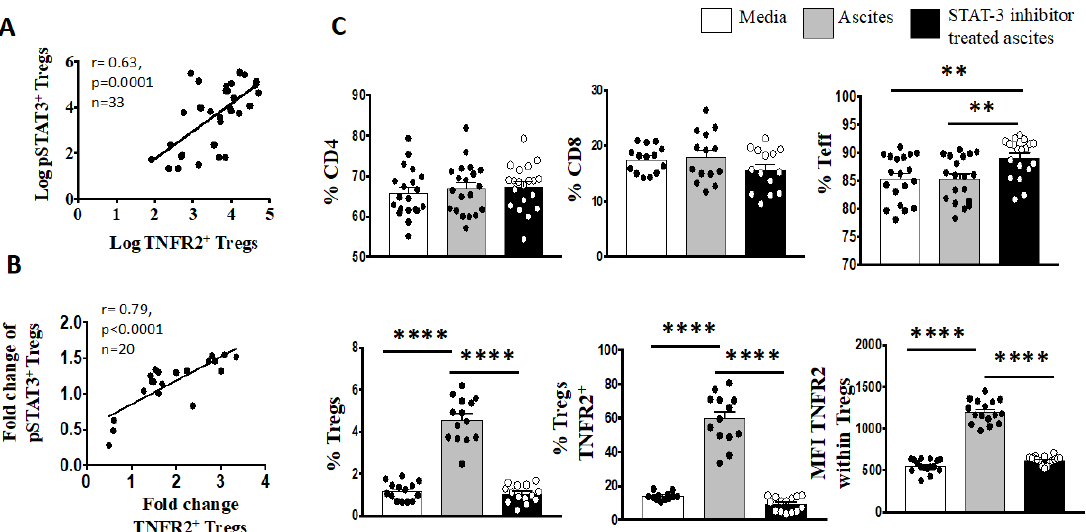
Figure 6. Blockade of pY705-STAT3 signaling decreases percentage of Tregs, as well as TNFR2+ Tregs and TNFR2 expression. ( A ) Peripheral blood mononuclear cells (PBMCs) from patients with advanced HGSOC ( n = 33) were isolated by Ficoll density centrifugation and freshly stained for surface and intracellular markers CD3, CD4, CD25, TNFR2, FoxP3 and pSTAT3 and analysed with flow cytometry. ( B , C ) PBMCs from healthy donors ( n = 20) were isolated by Ficoll density centrifu- gation and incubated in vitro in media or cell-free ascites from advanced EOC patients for 48 h. pY705-STAT3 activity was inhibited by the addition of 50 μM S3I-201 into the culture at day 0. In untreated media and ascites, vehicle control DMSO at 0.05% was added at day 0. Cells were washed, labeled for surface and intracellular markers CD3, CD4, CD25, TNFR2, FoxP3 and pSTAT3, and analysed with flow cytometry. ( A , B ) Correlation of the percentage of pSTAT3+ Tregs to TNFR2+ Tregs (log) in patients with advanced HGSOC. B. Correlation of the fold change of pSTAT3+ Tregs to TNFR2+ Tregs in healthy donors PBMC following incubation in ascites of EOC patient, p < 0.05 is significant. ( C ) The frequency (%) of CD4, CD8, Teff and Tregs as well as the percentage of TNFR2 and level of TNFR2 expression (median fluorescence intensity, MFI) within Tregs within media (white bar), ascites (grey bar) and following blockade with STAT3 inhibitor (black bar). ** p = 0.001–0.01, **** p < 0.0001—one-way ANOVA and Dunn’s multiple comparison test (post-hoc). Data are pooled from two independent experiments (error bars—SEM). 4. Discussion The present study shows for the first time that the combination of suppressive and pro-inflammatory immune markers, TNFR2-expressing Tregs and IL-6, found to be over- expressed in the peripheral blood of advanced high-grade serous ovarian cancer patients at diagnosis, are the most informative immune markers able to discriminate between those with ovarian cancers, benign ovarian masses and normal ovaries, and have superior predictive abilities compared to conventional tests and current biomarkers when used in combination. We found a positive correlation between the proportion of TNFR2-express- ing Tregs and STAT3-expressing Tregs in all patients with advanced HGSOC. We further investigated their relationship in an in vitro culture system by incubating PBMCs from healthy donors in malignant ascites containing high levels of IL-6. Confirming previous results, IL-6 in malignant ascites promoted TNFR2 expression on Tregs [57], and herein we further identified that the IL-6-mediated TNFR2 modulation of Tregs may operate via the constitutive phosphorylation of the STAT3 Y705. In our study, we assessed many soluble factors and phenotypic markers on T cells in the pre-treatment blood to identify discriminatory biomarkers using two robust statistical methods. We found that the concentration of IL-6 in the serum at baseline in malignancy